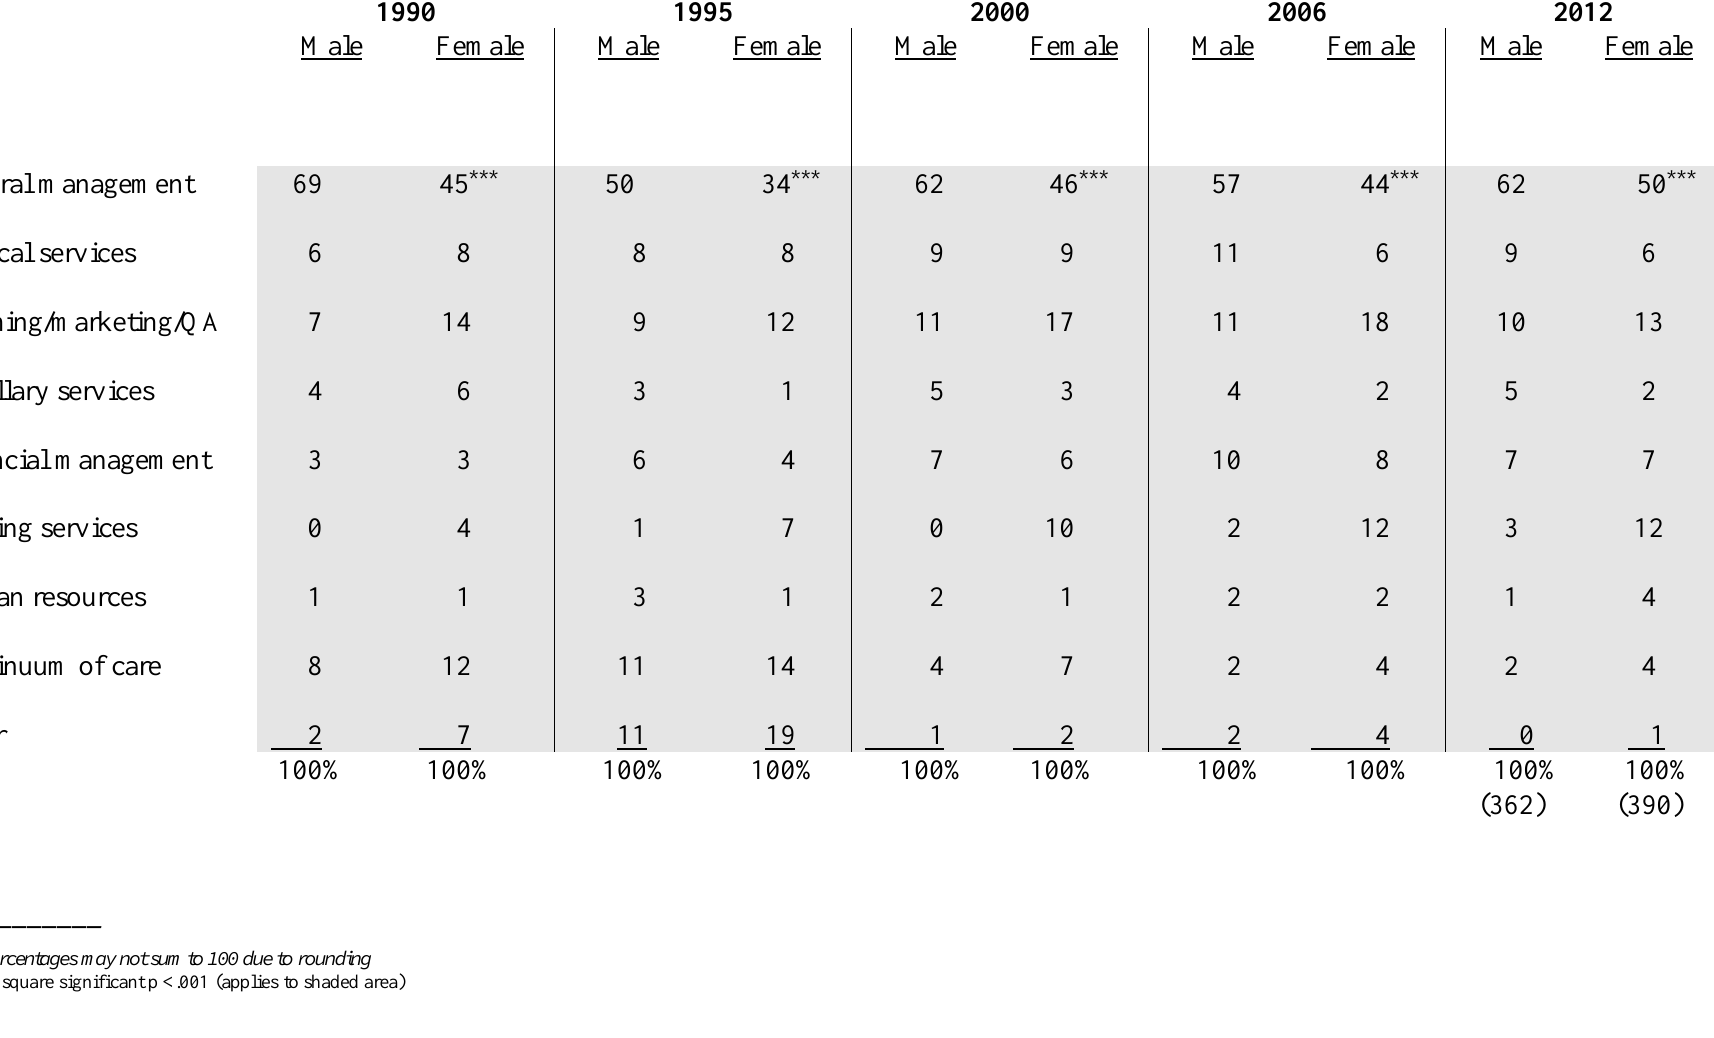
Table 5. Current Area of Responsibility by Gender and Year (percent) 1990 1995 2000 2006 2012 Male Female Male Female Male Female Male Female Male